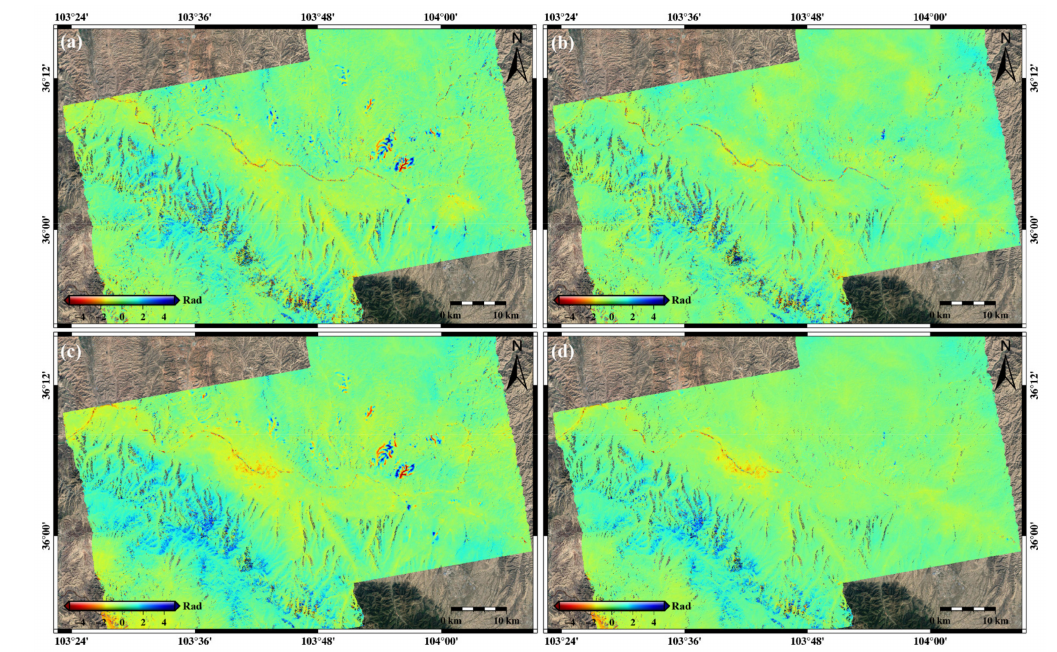
Figure 6. Exemplary unwrapped interferograms without (left) and with (right) DEM errors correction from ascending Sentinel-1 images: ( a ) interferogram generated between 6 November 2020 and 30 November 2020 before DEM errors correction, with spatial and temporal baselines of 150 m and 24 days, respectively; ( b ) the same interferogram after DEM errors correction; ( c ) interferogram generated between 18 November 2020 and 30 November 2020 before DEM errors correction, with spatial and temporal baselines of 148 m and 12 days, respectively; ( d ) the same interferograms after DEM errors correction.